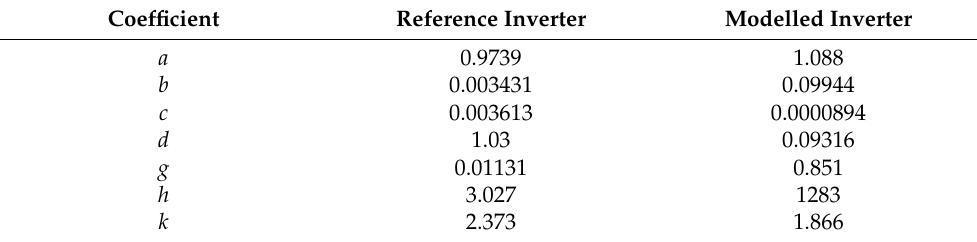
Table 1. Coefficients of the approximation of the inverter efficiency curves according to Equation (3).